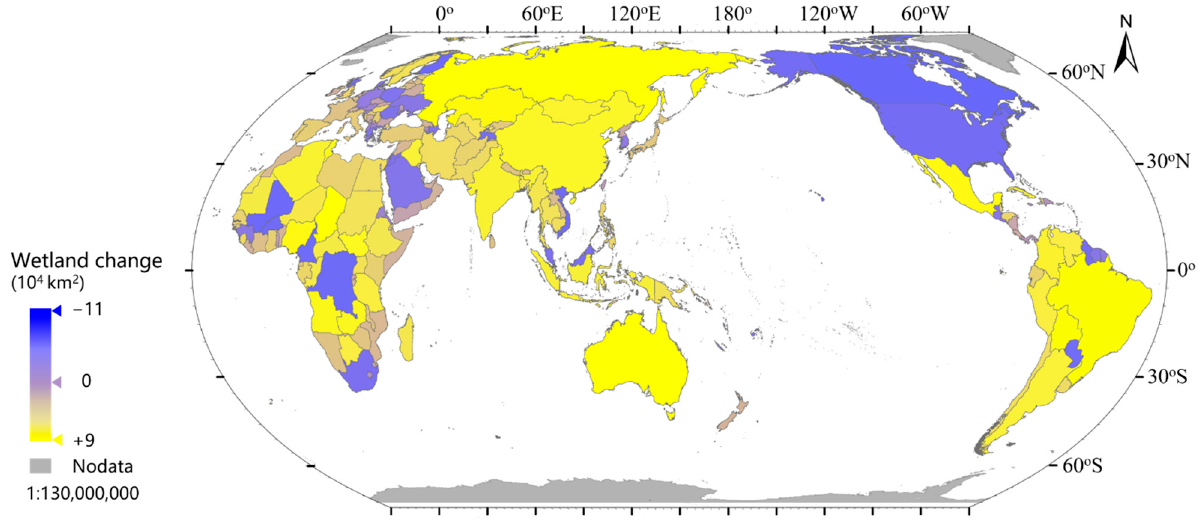
Figure 11. The wetland area changes of global countries from 2000 to 2020.